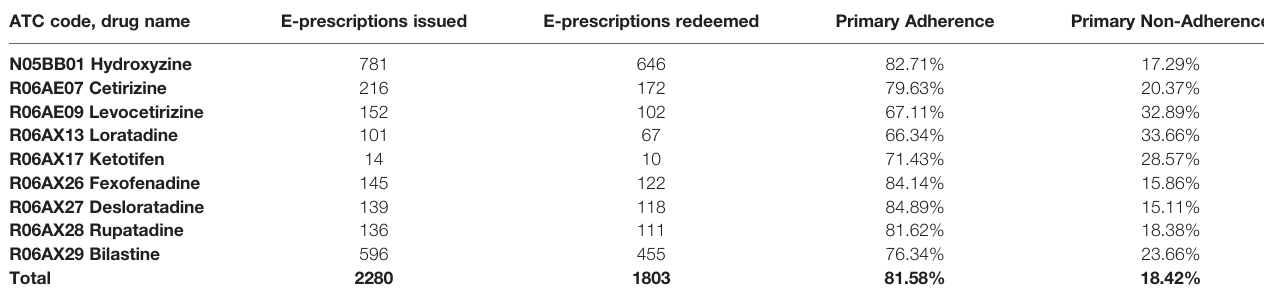
TABLE 3 | Primary non-adherence to individual